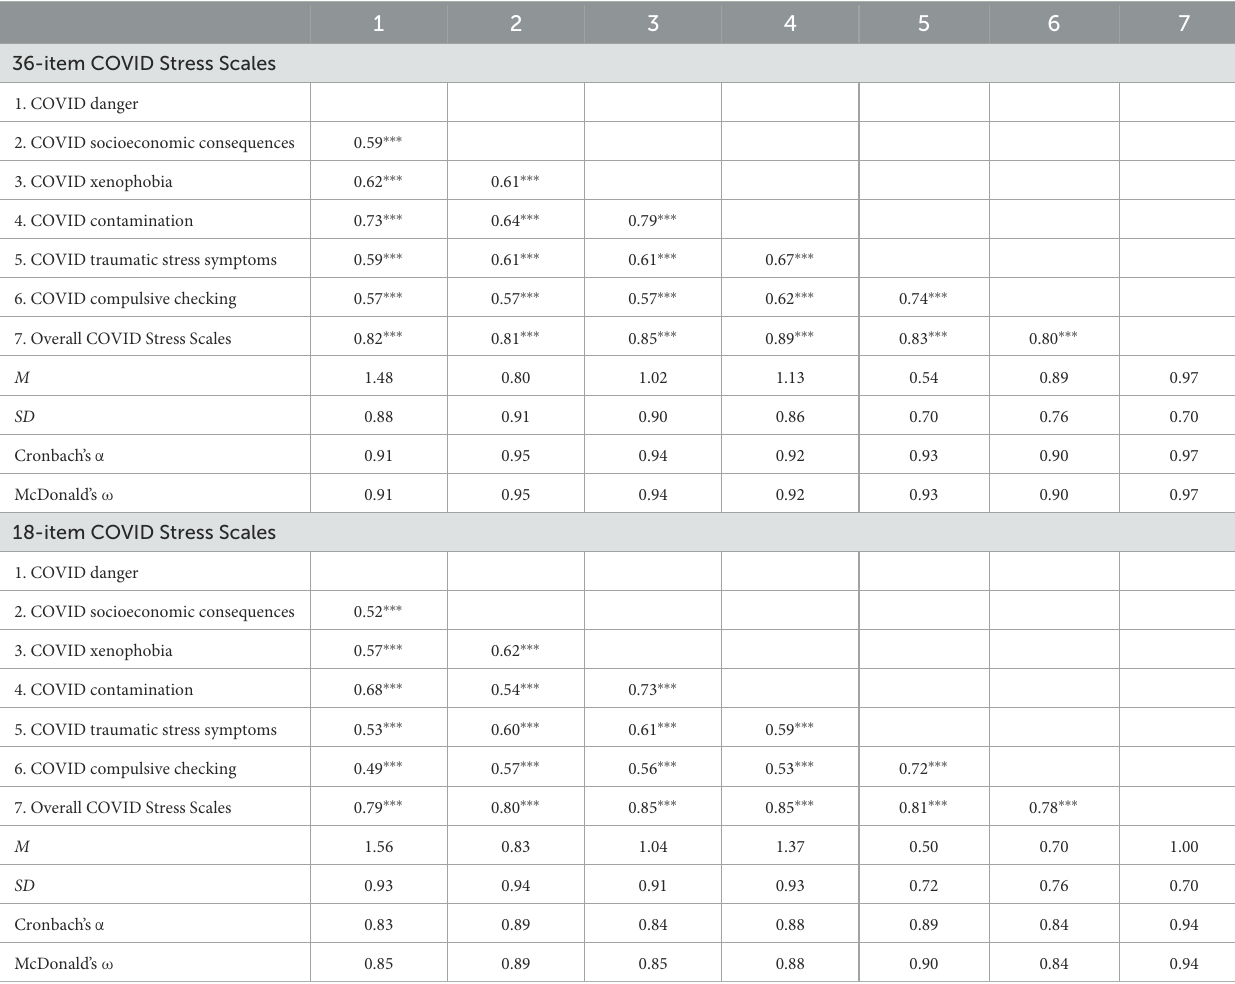
TABLE 4 Descriptive statistics and correlations of the COVID Stress